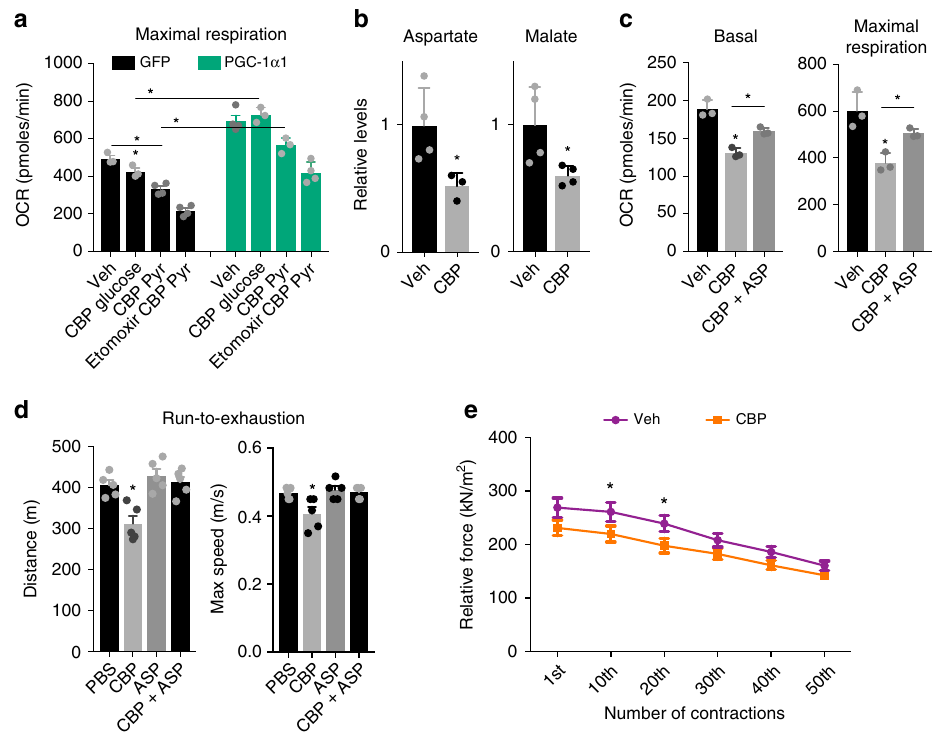
Fig. 4 Kat-inhibition by carbidopa impairs malate-aspartate metabolism in skeletal muscle. a Maximal respiration measured by Extracellular Flux Analysis (Seahorse TM ), in the presence of Glucose or Pyruvate (Pyr), in primary myotubes transduced with Gfp control or Pgc-1 α 1 adenovirus and supplemented with 40 μ M carbidopa (CBP) for 24 h and/or 50 μ M Etomoxir for 1 h ( n = 4). b Relative levels of aspartate and malate in primary myotubes supplemented with 40 μ M carbidopa for 24 h. c Basal and maximal respiration of primary myotubes supplemented with 40 μ M carbidopa for 24 h or 40 μ M carbidopa for 24 h followed by 100 μ M aspartate (ASP) for 1 h. d Mouse exercise performance test shown as distance and maximal speed after 4 days of intraperitoneal injection of PBS, carbidopa, aspartate or carbidopa + aspartate ( n = 5). e Tetanic force was measured at 70 Hz force with 350 ms tetani at 2 s intervals for 50 contractions in skeletal muscle of mice after 4 days of intraperitoneal injection of PBS or carbidopa ( n = 4). Bars depict mean values and error bars indicate SEM. Unpaired, two-tailed student ’ s t -test was used when two groups were compared, and one-way analysis of variance (ANOVA) followed by Fisher ’ s least signi fi cance difference (LSD) test for post hoc comparisons were used to compare multiple groups, * p <